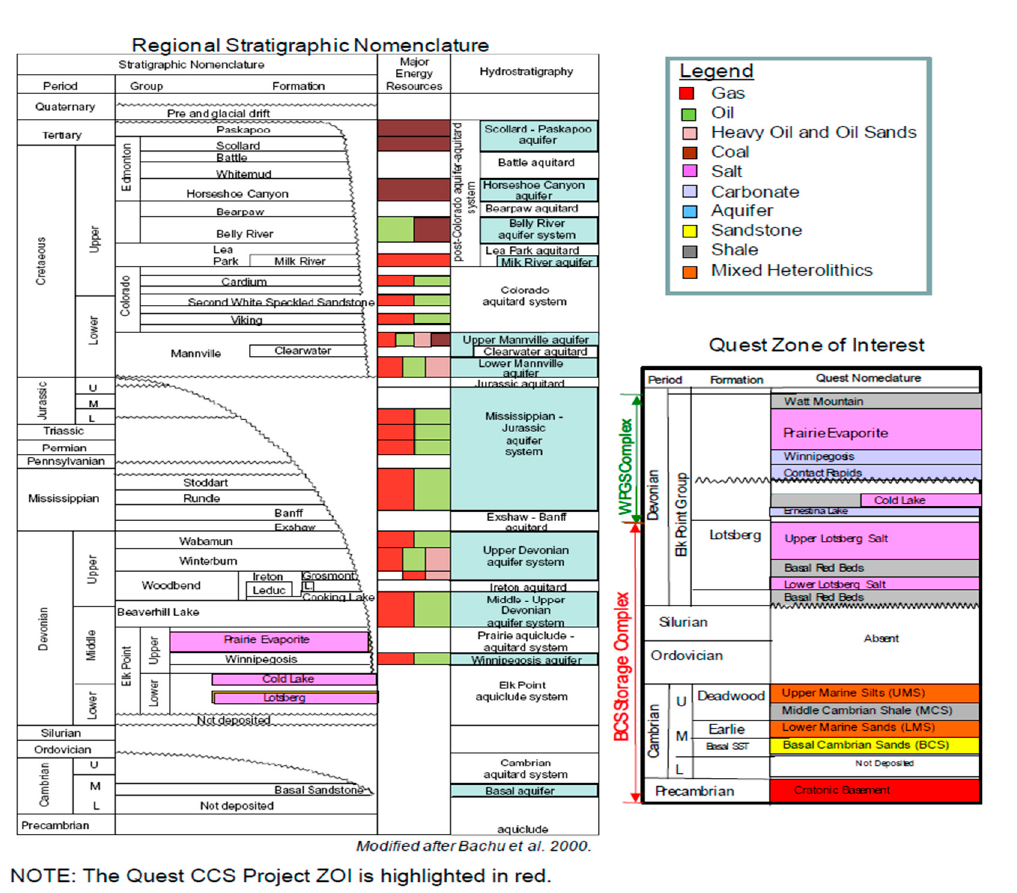
Figure 14. Geological profile of the southern and central Alberta basin, and the injection site for the Quest CCS project